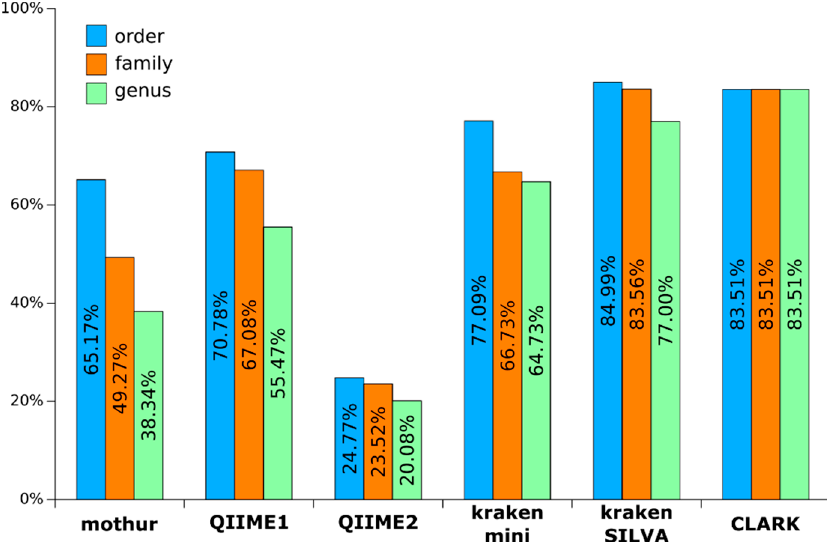
Figure 2. Assigned read proportions for each pipeline to di ff erent taxonomic levels (i.e., order, family and genus).